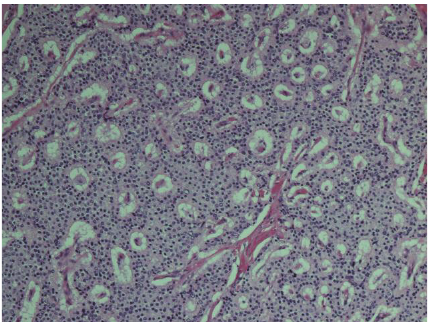
Figure 2: Characteristic microscopic appearance of carcinoid tum-